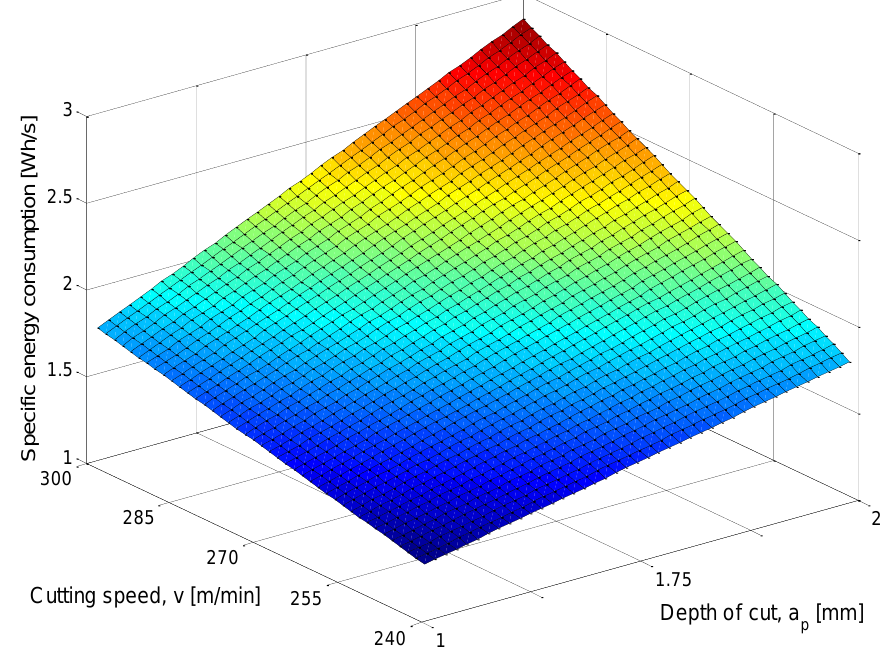
Figure 13. Change in STEC with respect to cutting speed and depth of cut.